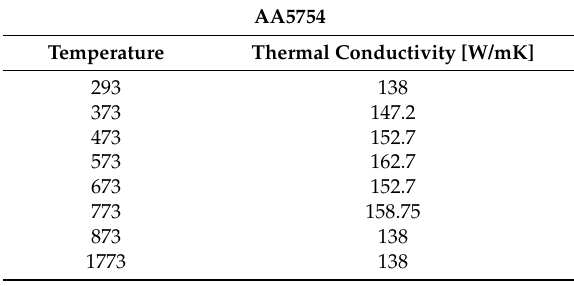
Table 3. Temperature dependent thermal conductivity of AA5754.